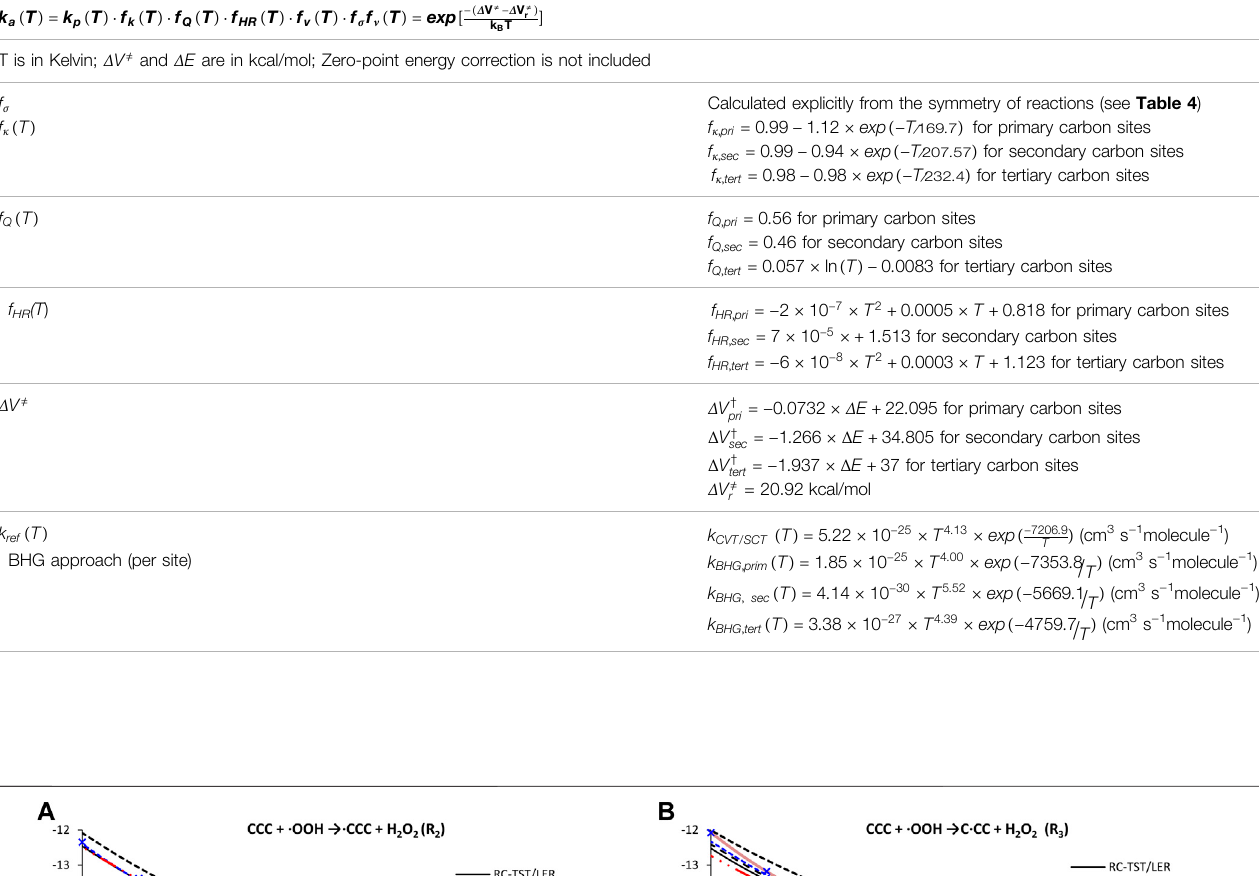
TABLE5| ParametersandformulationsoftheRC-TSTmethodforthe · OOH+alkane → alkyl+H 2 O 2 reactionclass(C 2 H 6 + · OOH → · C 2 H 5 +H 2 O 2 isthereferencereaction), units of rate constants are ( cm − 3 s − 1 molecule − 1 ).